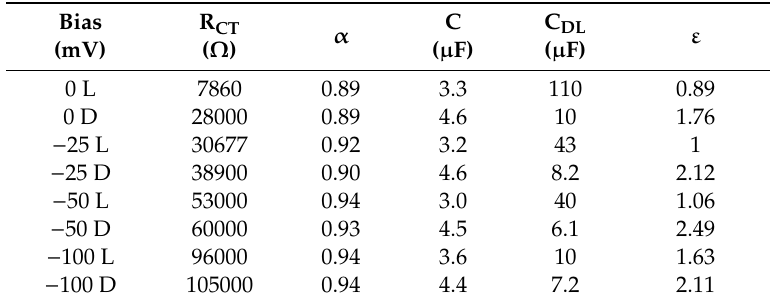
Table 1. EEC parameters for Dataset 1. Nominal impedance solution is less than 63 Ω .